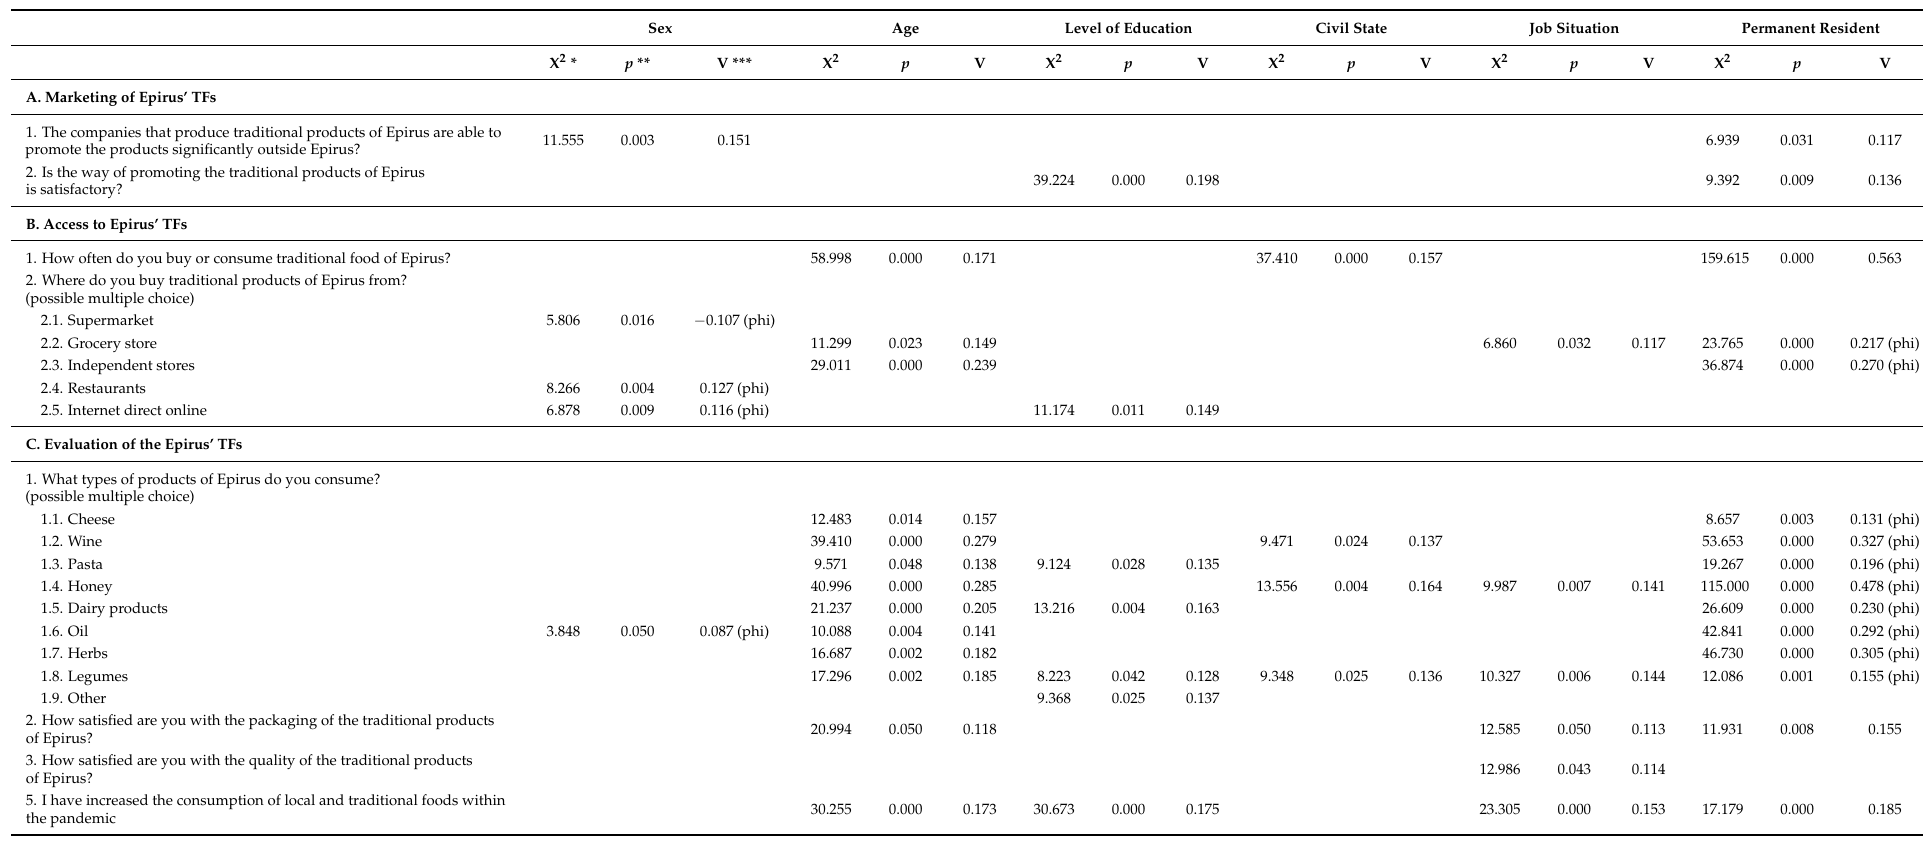
Table 6. Associations between variables (A) marketing of TFs, (B) access to TFs, and (C) evaluation of TFs of Epirus and the sociodemographic variables. Sex Age LevelofEducation CivilState JobSituation